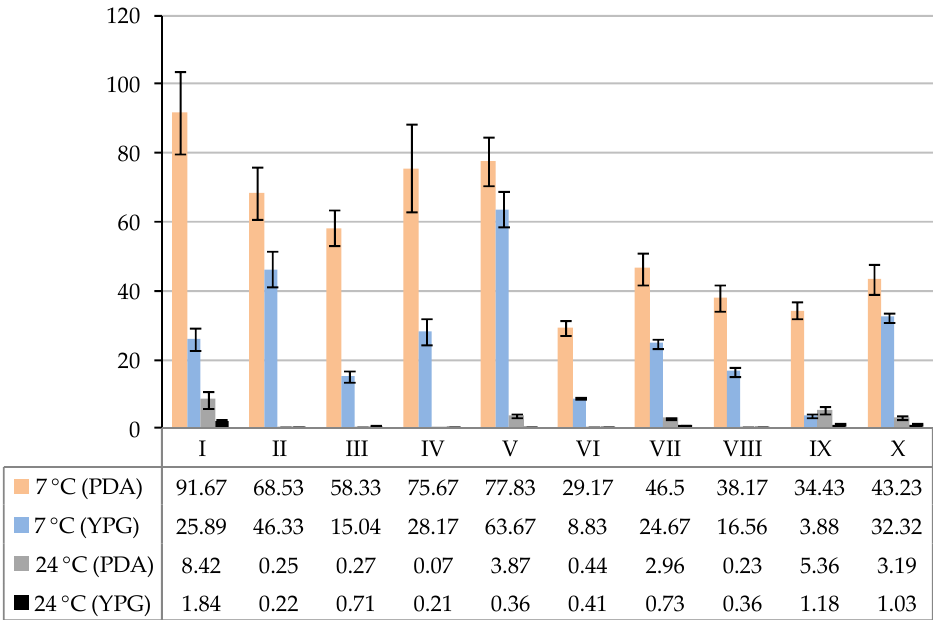
Figure 2. The number (CFU × 10 2 per 1 g ± SD) of fungi cultured from the cryoconite holes in the Werenskiold Glacier (Spitsbergen) and incubated at 7 or 24 °C on PDA and YPG media: I–X—study sites.